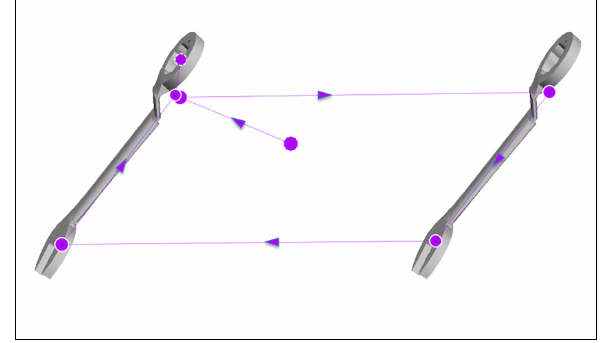
Figure 5: Gaze pattern 3 – Square Gaze Pattern 4: In the fourth gaze pattern not, the similar features of the opposite object are considered but the different ones (Figure 6). This gaze pattern looks unstructured. Hence, this gaze pattern most frequently leads to incorrect answers. We called this gaze pattern